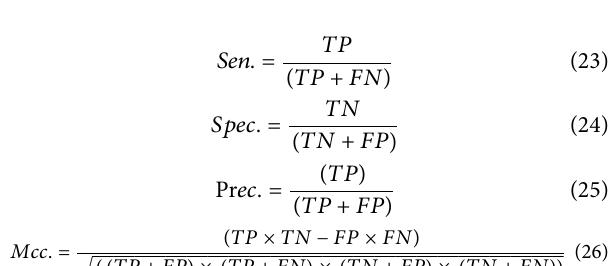
– recall curves generated by